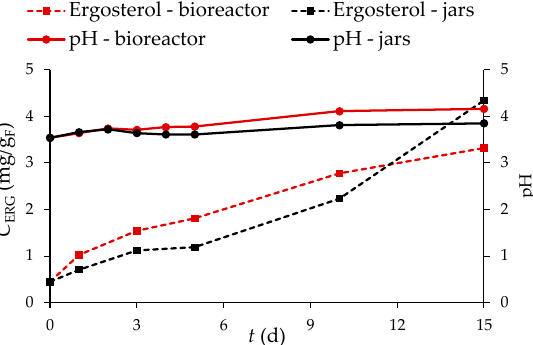
. Figure 3. Ergosterol concentration ( C ERG ) and pH of extracts obtained from GP before (day “0”) and during the 15-day SSF process by R. oryzae in laboratory jars and tray bioreactor.